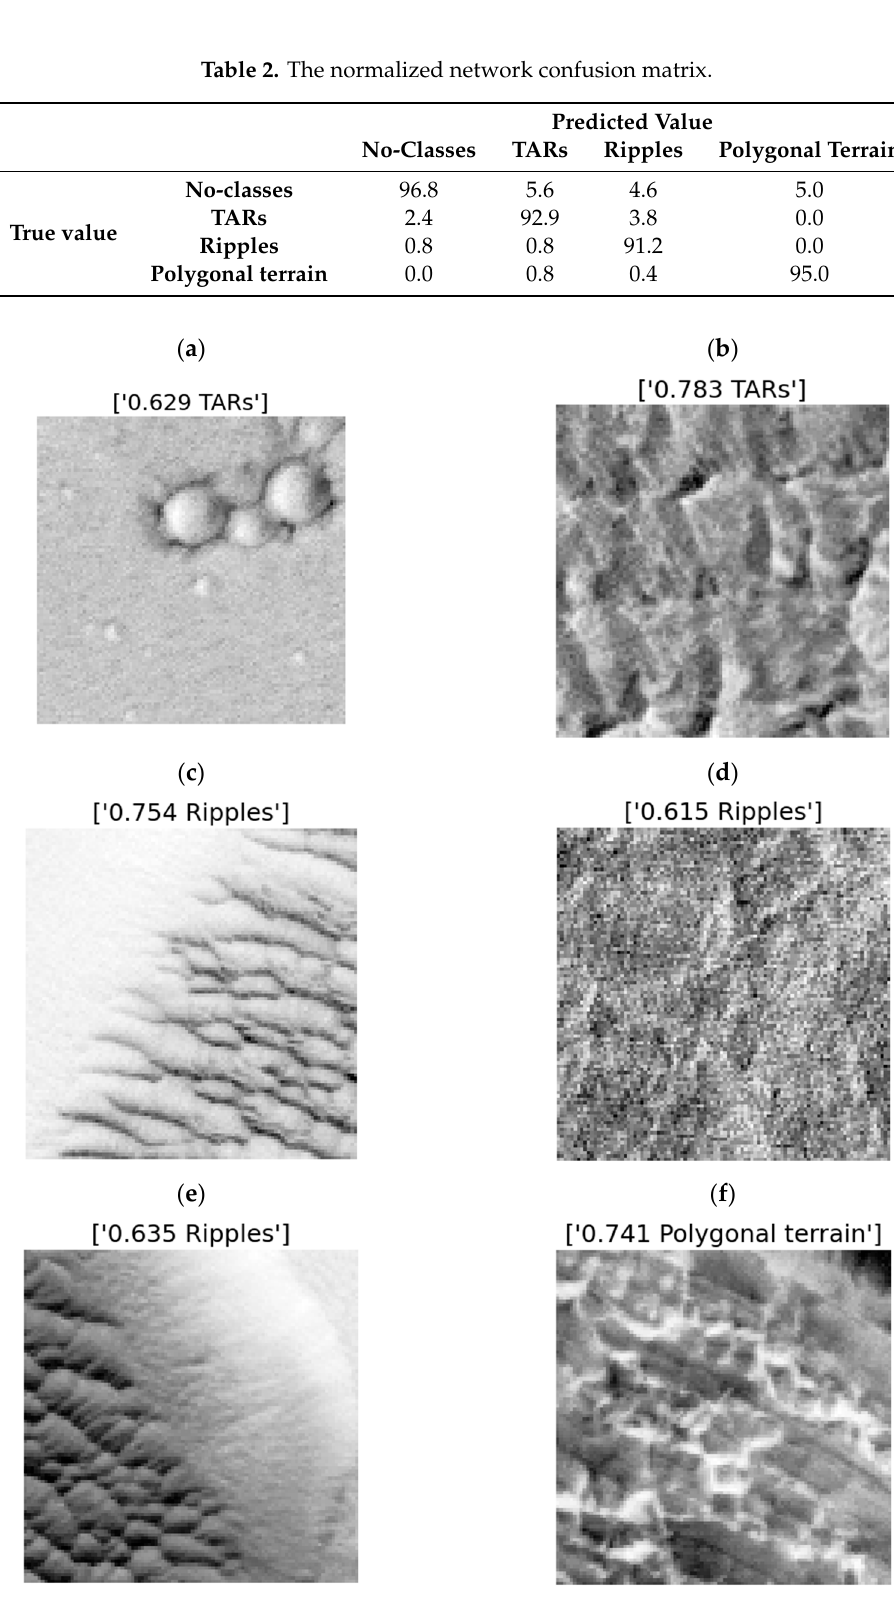
Figure 3. Rare incorrect detections. The text above each image is the model’s score and label. ( a ) Craters likely misclassified as networked TARs. Note the similarity to Figure 3(1b). ( b ) Hummocky terrain misclassified as TARs. ( c ) Dark TARs misclassified as ripples. ( d ) No-class terrain misclassified as ripples. The regular roughly horizontal banding error in the image is a likely cause. ( e ) Dark TARs again misclassified as ripples. ( f ) Unusually illuminated terrain misclassified as polygonal.